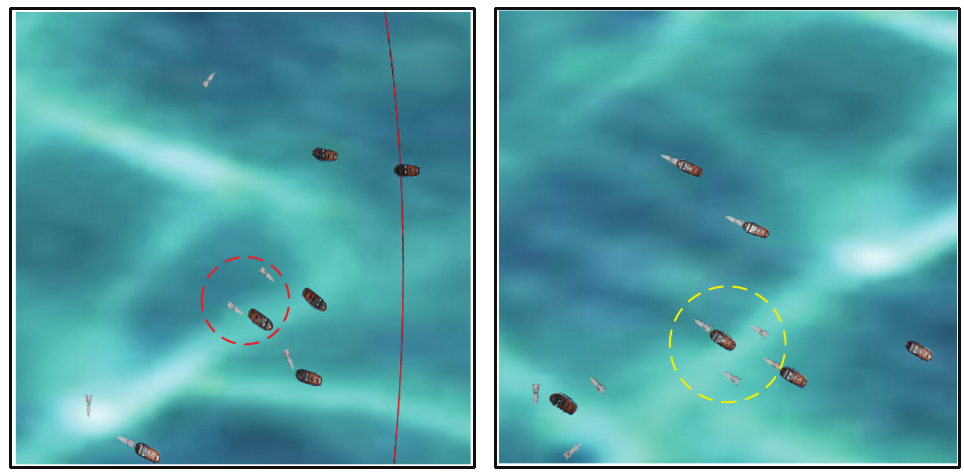
Figure 6. Typical confrontation details in the